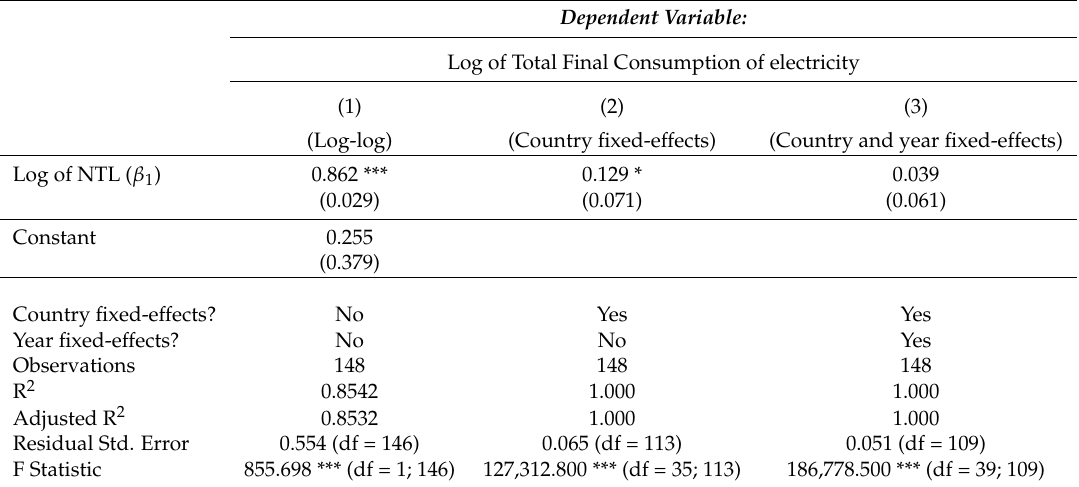
Table 5. Upper-middle income countries regression for TFC.